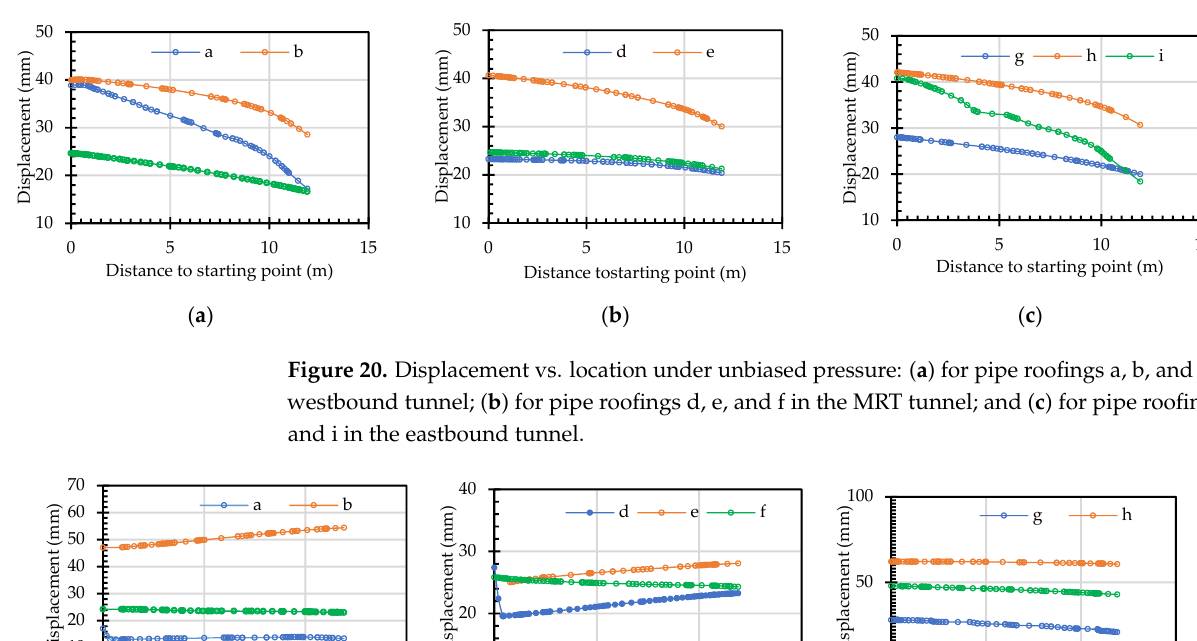
Figure 19. Schematic diagram of the locations of pipe roofings.